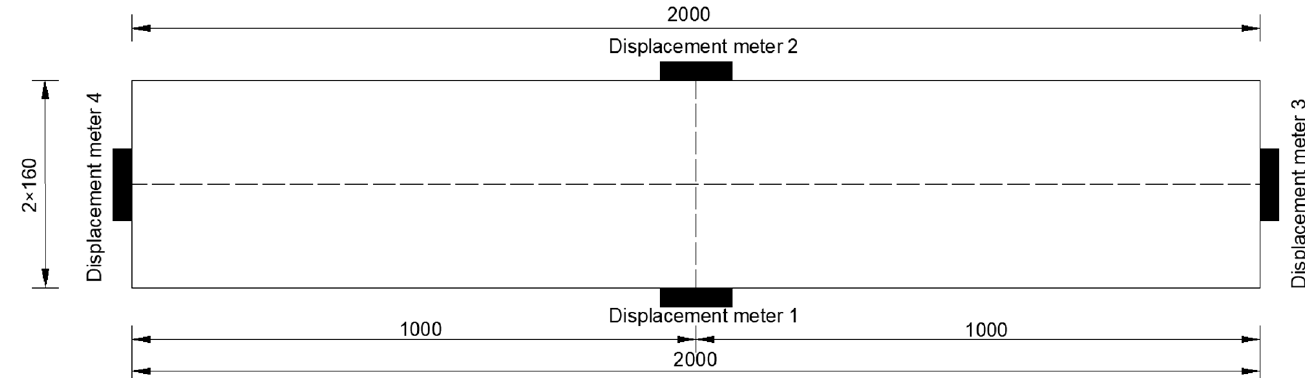
Figure 3. Layout of digital displacement meters in elevation on the test beam (mm).